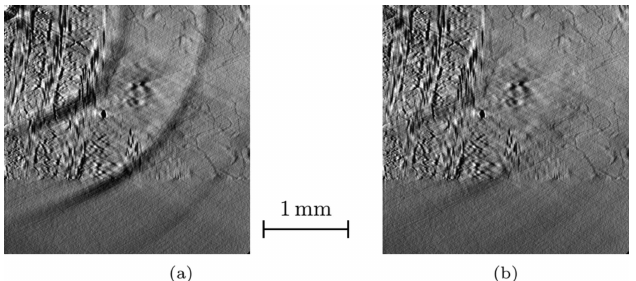
Figure 7 Correction of ring artefacts. Zoom on a horizontal slice of the reconstruction: the centre of rotation is at the upper left corner. The spots on the projections create dark rings in the gross reconstruction ( a ), which almost vanish on the corrected one ( b